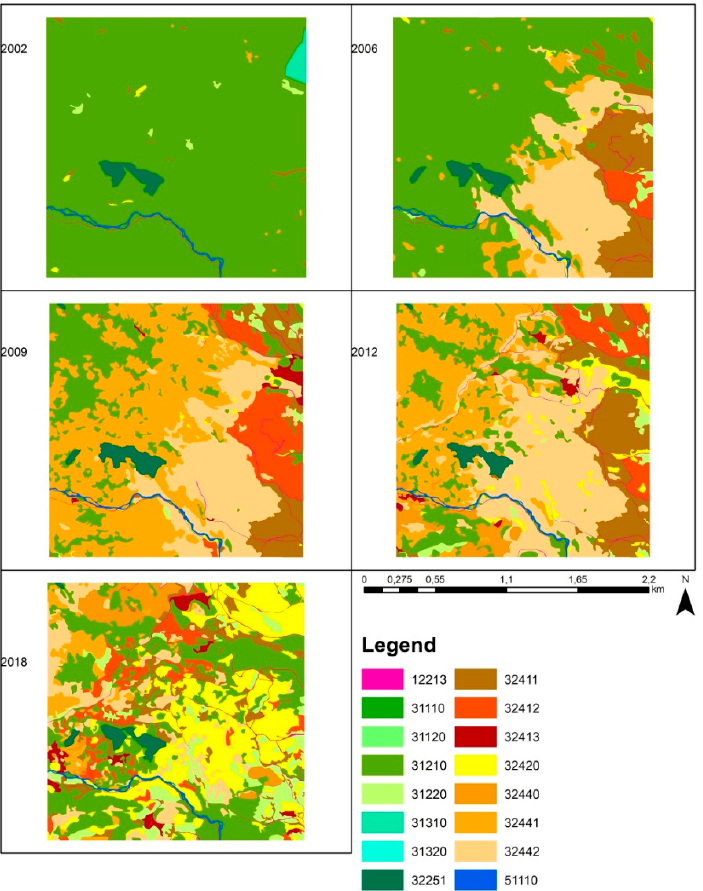
Figure 4. Detailed land cover maps of chosen TANAP area (NW from Tatranská Lomnica) in 2002–2019. Description of codes: 12213—Roads with an unpaved surface, 31110—Broad-leaved forests